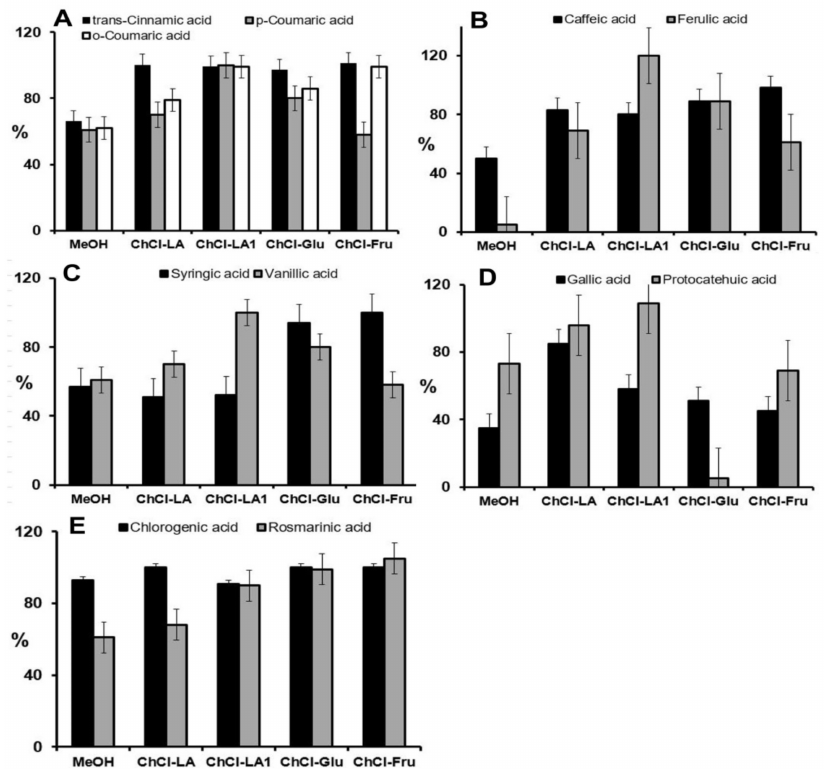
Figure 2. Extraction recoveries of spiked samples (%) for analysed phenolic acids (( A ) and ( B )-hydroxycinnamic acids; ( C ) and ( D )-hydroxybenzoic acids; ( E) -chlorogenic and rosmarinic acid) obtained after extraction with 80% MeOH and after extraction with di ff erent NADESs.